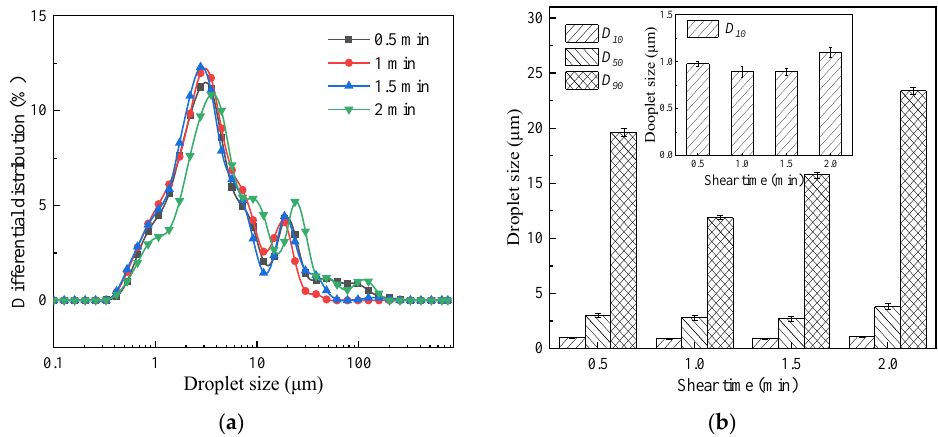
Figure 4. Droplet size distribution of asphalt emulsions fabricated at different shear time. ( a ) Droplet size distribution; ( b ) Representative droplet sizes.